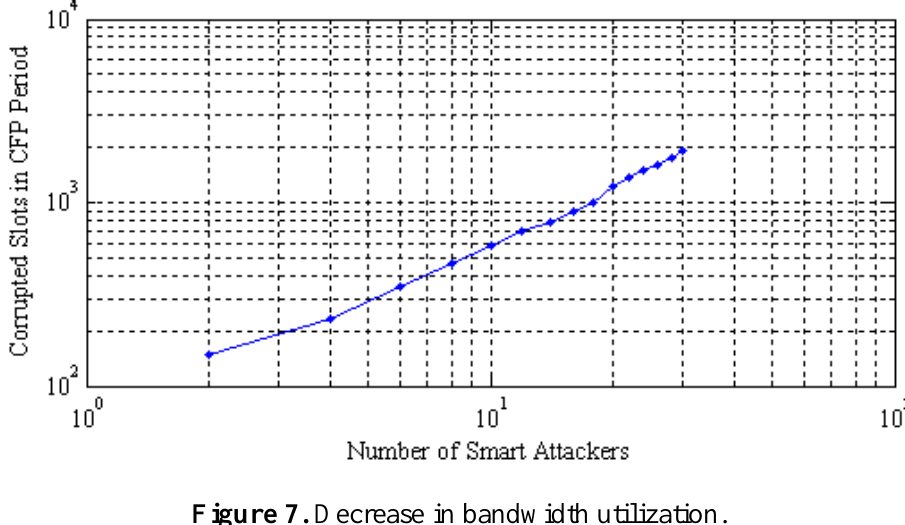
Figure 7. Decrease in bandwidth